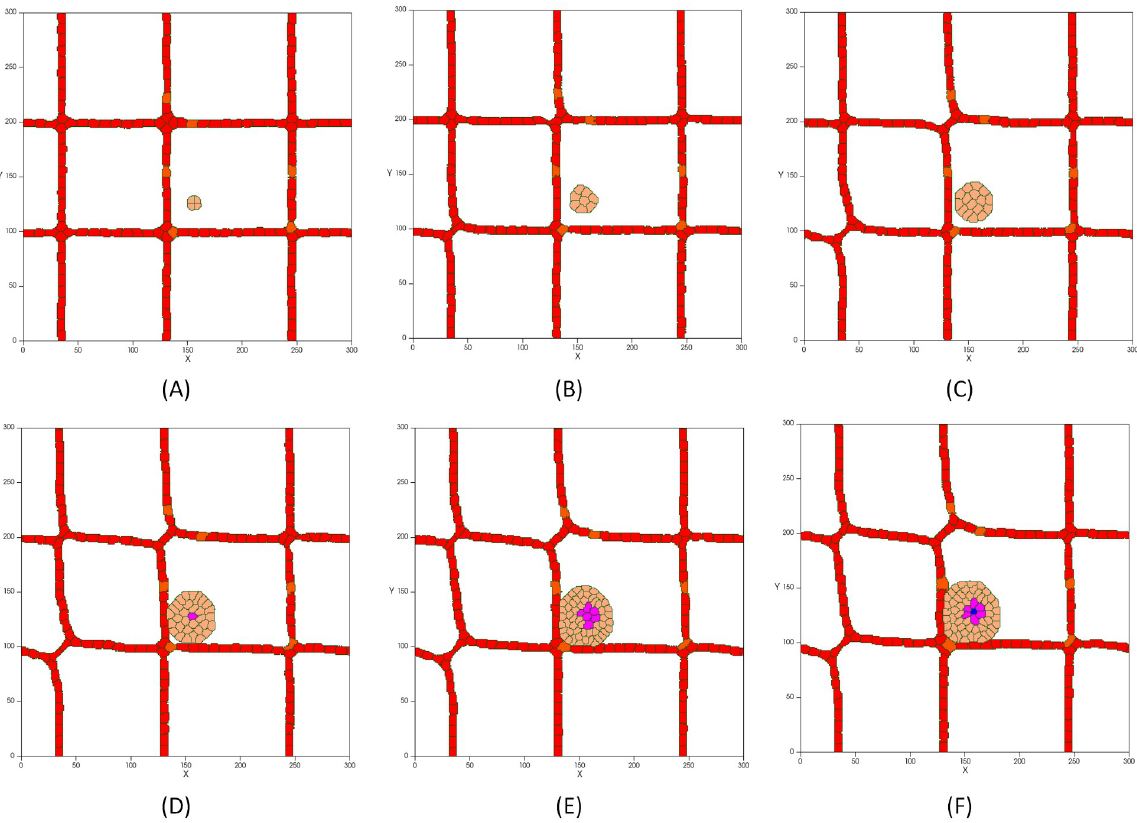
Fig 6. First steps of tumor avascular development in the presence of a vascular network: (A) Initial tumor with proliferating and migrating cells and a diameter of 51 μ m on day 1. (B) The growing tumor reaches a diameter of 100 μ m on day 2. (C) The tumor continues to grow up to a diameter of about 142 μ m on day 3. (D) Cells in the core of the tumor with a diameter of about 200 μ m suffer from hypoxia and change their phenotype to quiescent (hypoxic cells are in purple). (E) As the tumor grows, lack of oxygen increases leading to expansion of the hypoxic core. (F) Shortage of oxygen and nutrients in the hypoxic region leads to necrosis after 20 hours on day 5 (necrotic cells are in